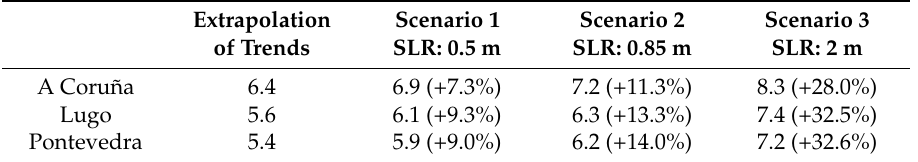
Table 6. FL50 projections for 2100 by extrapolating trends and for three SLR scenarios by provinces.